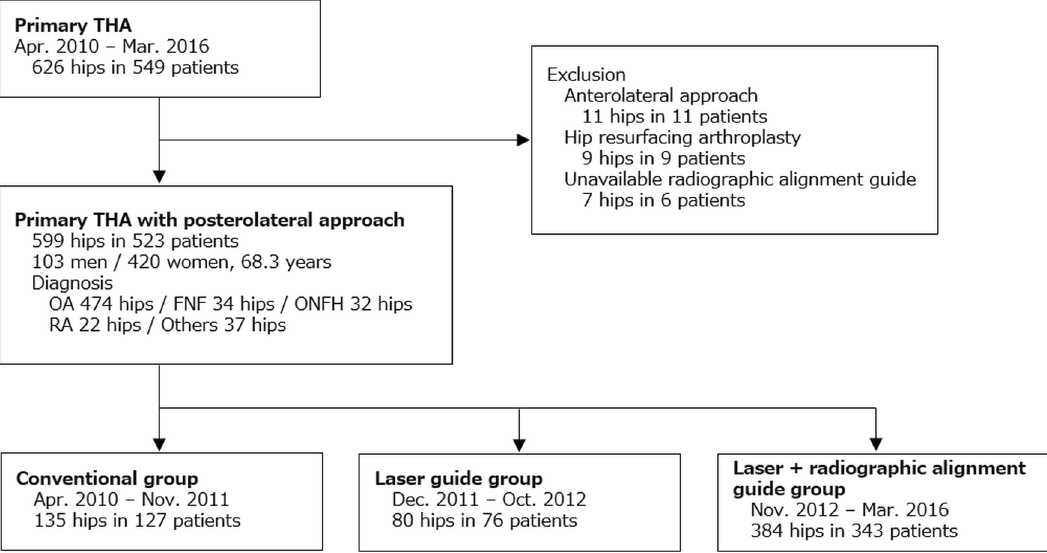
Figure 1. Patients selection. Demographic data and grouping by surgery period. THA total hip arthroplasty, OA osteoarthritis, FNF femoral neck fracture, ONFH osteonecrosis of the femoral head, RA rheumatoid